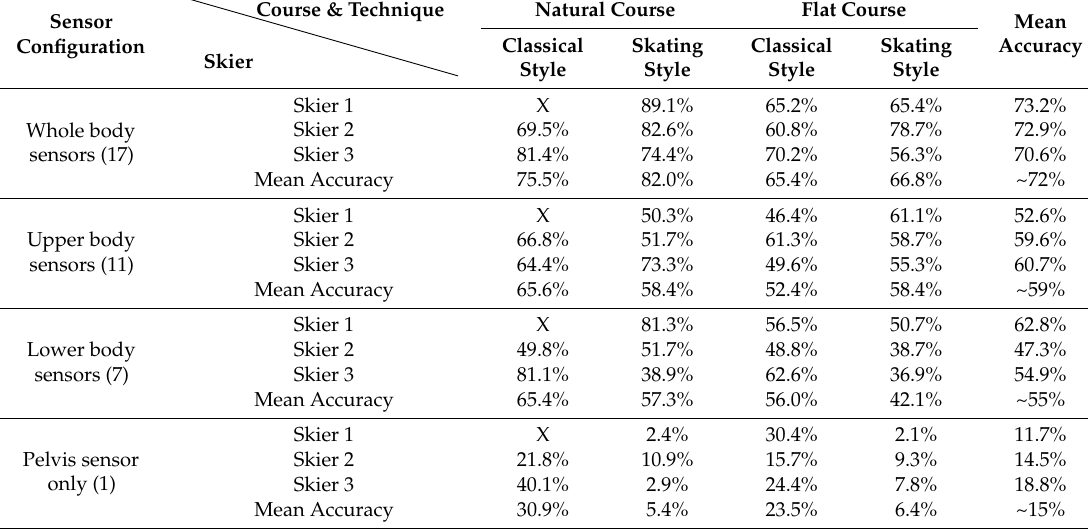
Table A9. Classification accuracies for the first three skiers using the k-nearest neighbors algorithm when a leave-one-out type of testing is performed using four different sensor configurations of